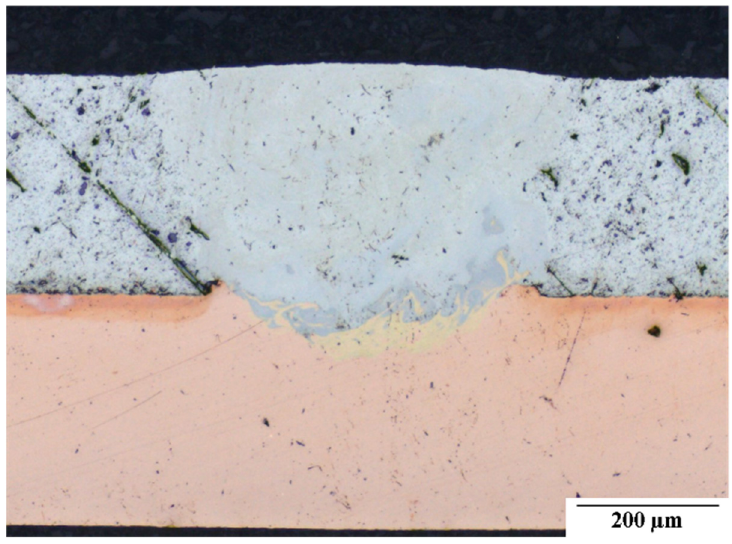
Figure 1. Cross section of a laser welded aluminium and copper joint ( P = 294 W, v = 120 mm/s, A = 0.15 mm, f = 1000 Hz).